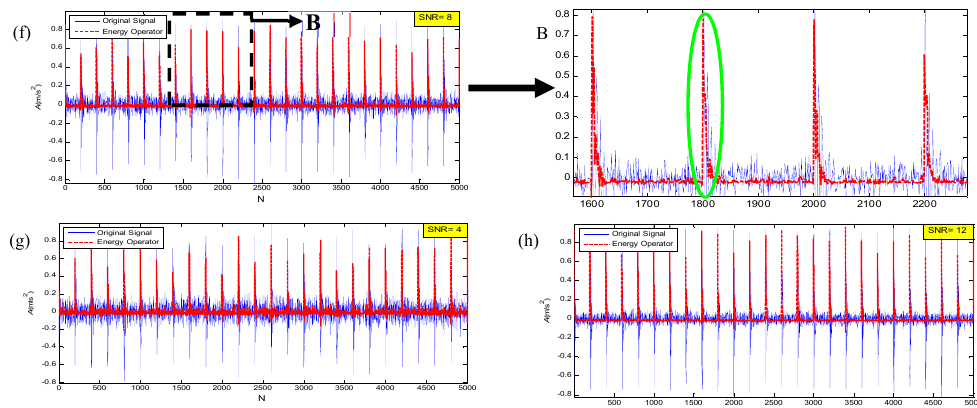
Figure 3. The diagram of Teager energy operator under different SNRs, ( a ) –16 dB, ( b ) –12 dB, ( c ) –8 dB, ( d ) –4 dB, ( e ) 0 dB, ( f ) 4 dB, ( g ) 8 dB, ( h ) 12 dB. A—the partial enlargements of ( e ); B—the partial enlargements of ( f ).